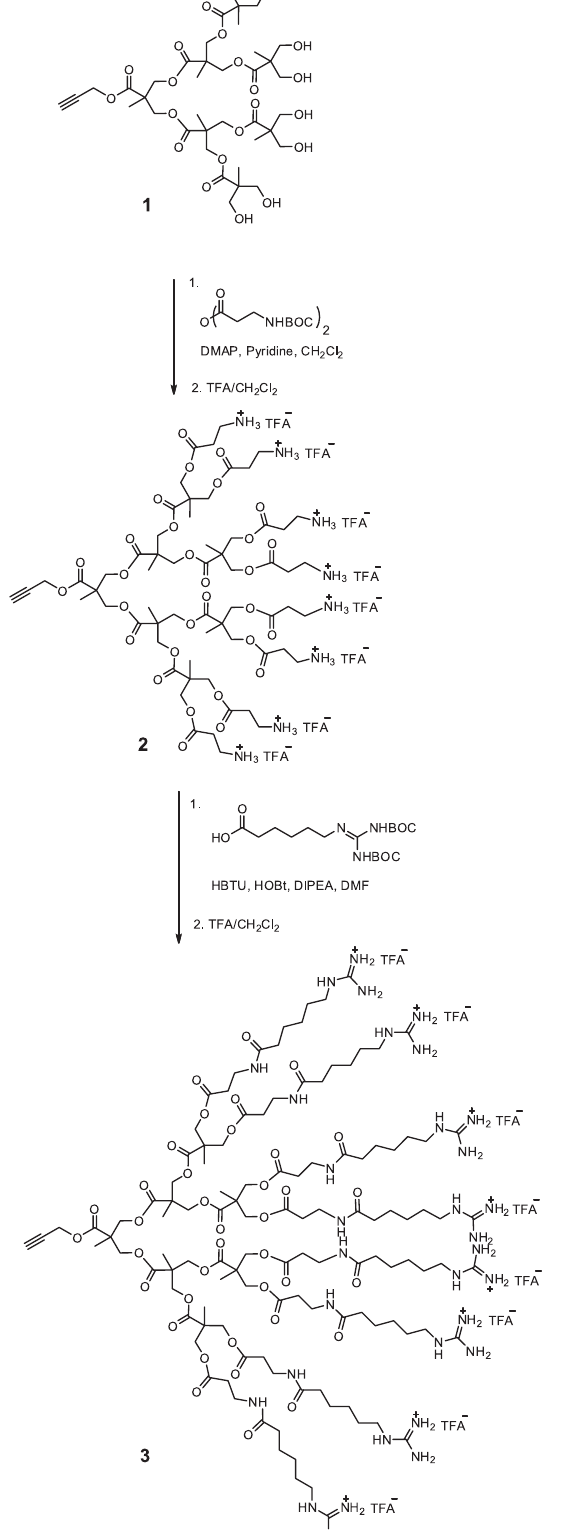
FIGURE 2 - Synthesis of hydroxyl 1 , amine 2 , and guanidine 3 functionalized